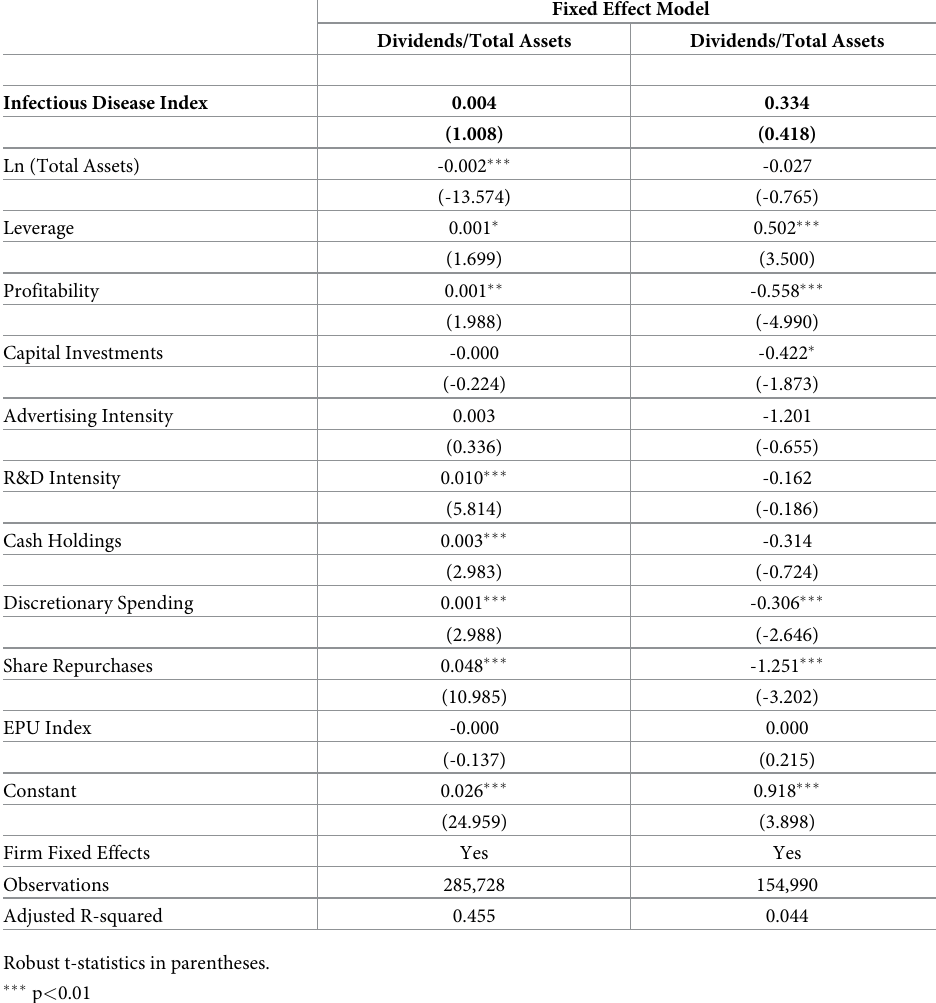
Table 4. Regression analysis on fixed effect model. Our measure of disease-related uncertainty is the infectious dis- ease equity market volatility developed by Baker et al. (2020) [9]. Using sophisticated textual analysis, Baker et al. (2020) [9] search for news articles related to infectious diseases and equity market volatility. A higher fraction of these news articles to all articles in each time period signifies a higher level of market uncertainty that can be ascribed to infectious diseases. For ease of interpretation, we have the infectious disease equity market volatility index divided by